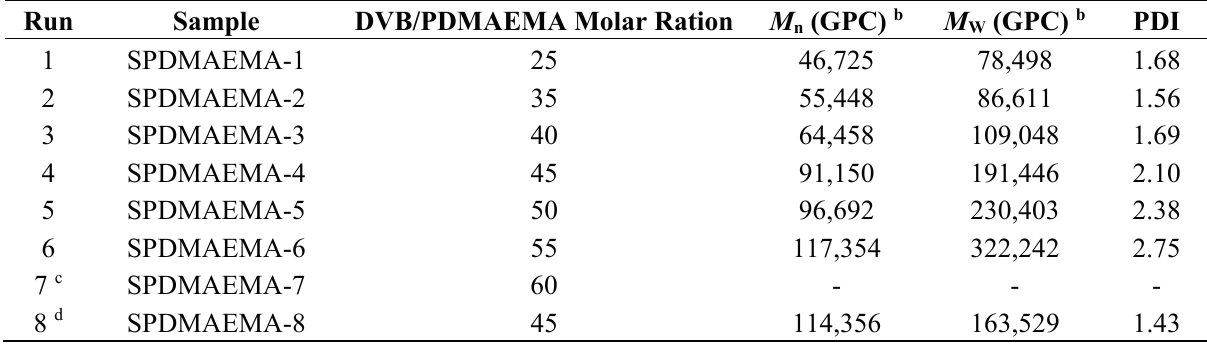
Table 2. The effects of DVB/PDMAEMA-CPTCD molar ration on the formation of star polymers from RAFT polymerization of DVB a .